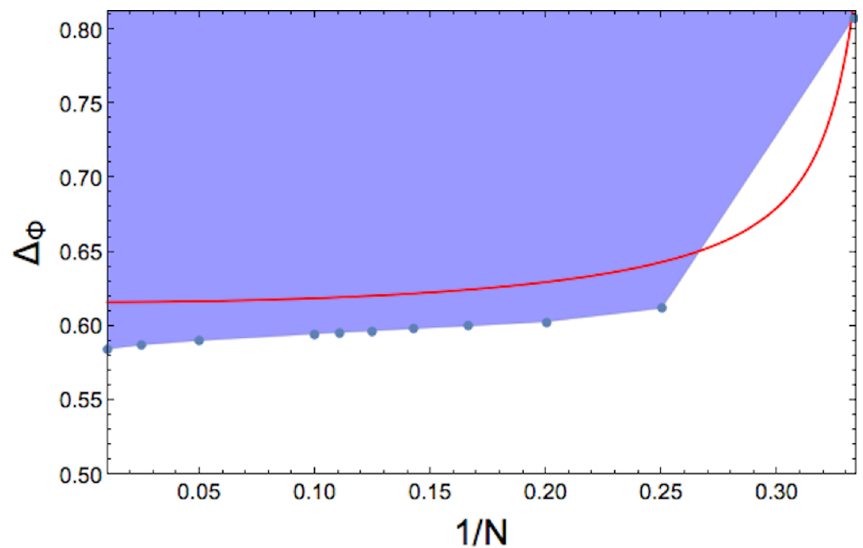
as a function of the flavor Φ using (cid:15) -expansion. Φ